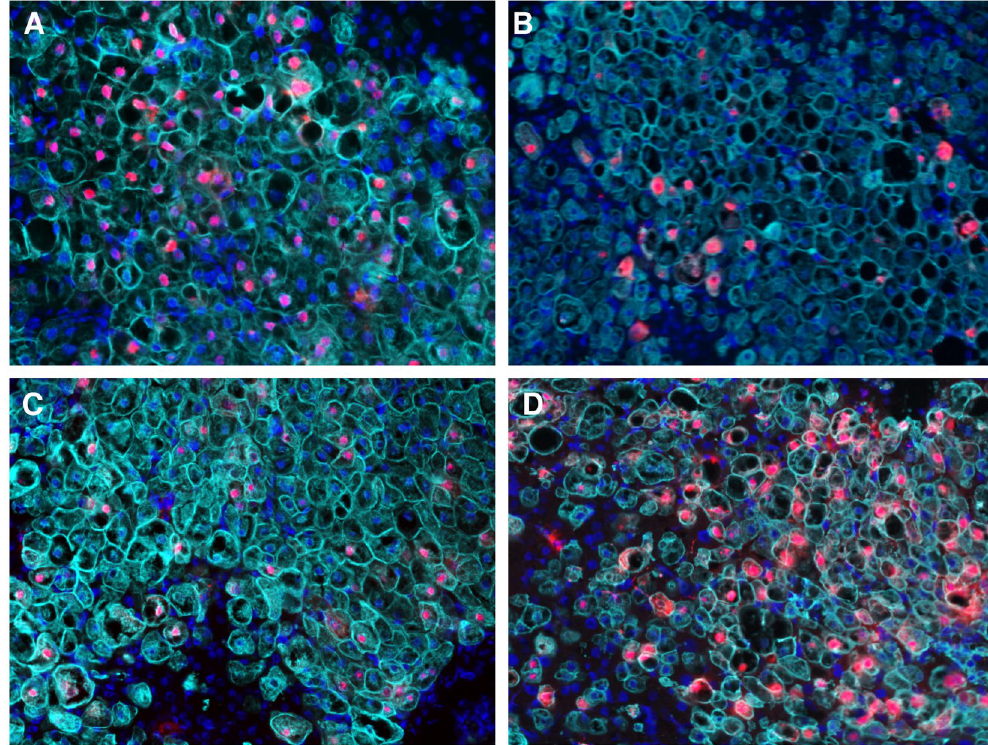
Figure 2. Intrahepatic HDAg changes upon treatment. Immunofluorescence staining of HDAg (red) and human hepatocytes (CK18, light blue) in humanized liver specimen of untreated control mice ( A ) or mice either treated with peg-INF α ( B ), peg-INF λ ( C ) or ETV ( D ). Nuclei are stained in dark blue (Hoechst